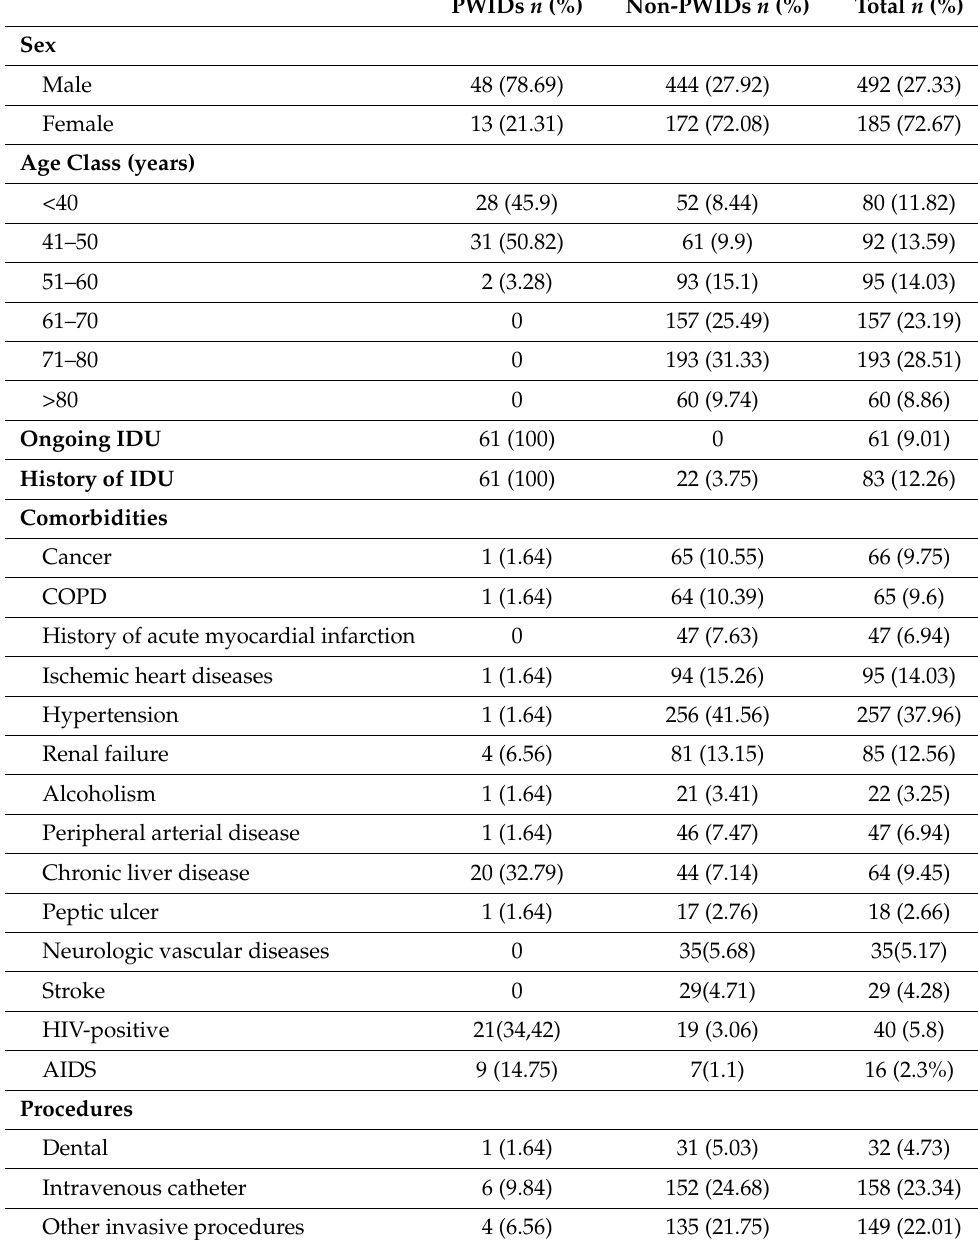
Table 1. Patient characteristics and